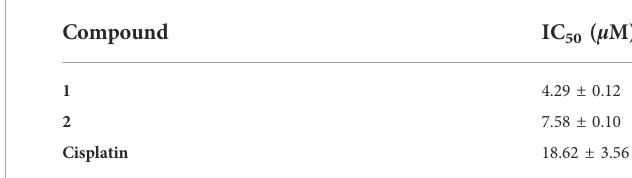
TABLE4 Invitro cytotoxicactivityofcomplexes1and2againstMCF-7 cell